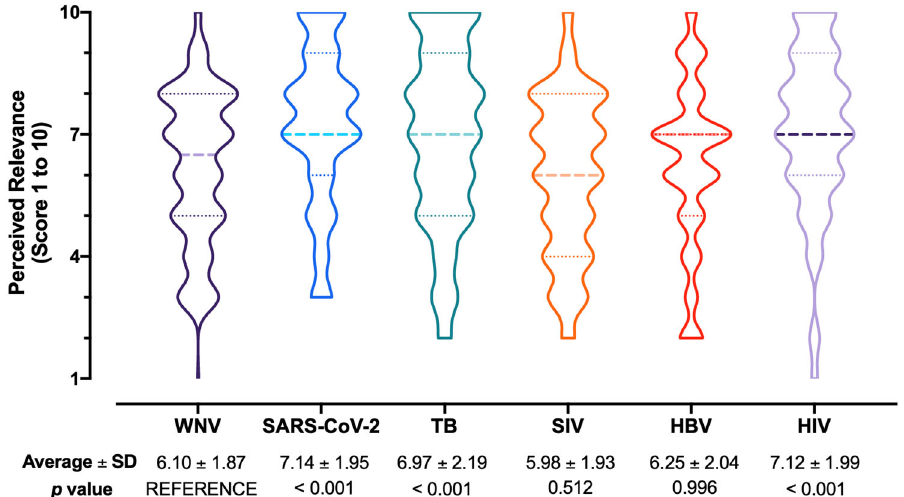
Figure 3. Box and violin plot for the perceived burden on National Health Service of West Nile virus in- fections (WNV) compared to SARS-CoV-2, tuberculosis (TB), seasonal influenza virus (SIV), hepatitis B virus (HBV), and human immunodeficiency virus (HIV) infections. Comparisons were performed by means of the Kruskal–Wallis test for multiple comparisons by assuming WNV/WNF/WNND as the reference